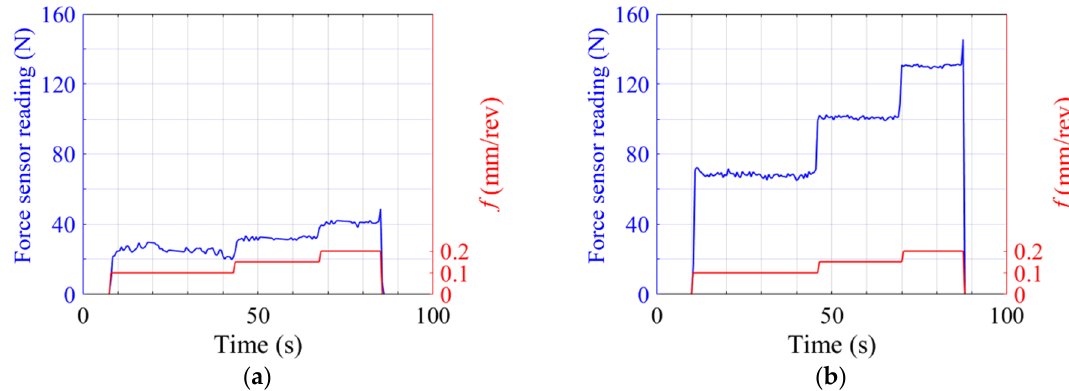
Figure 18. The force sensor readings of the smart tool holder at the working condition of varying feed rate ( f ). The cutting length is 90 mm, f is changed every 30 mm in the order of 0.1 mm/rev, 0.15 mm/rev, and 0.2 mm/rev, and the constant cutting depth is, respectively, ( a ) ap = 0.1 mm; and ( b ) ap = 0.3 mm. The spindle rotates at 500 rpm.